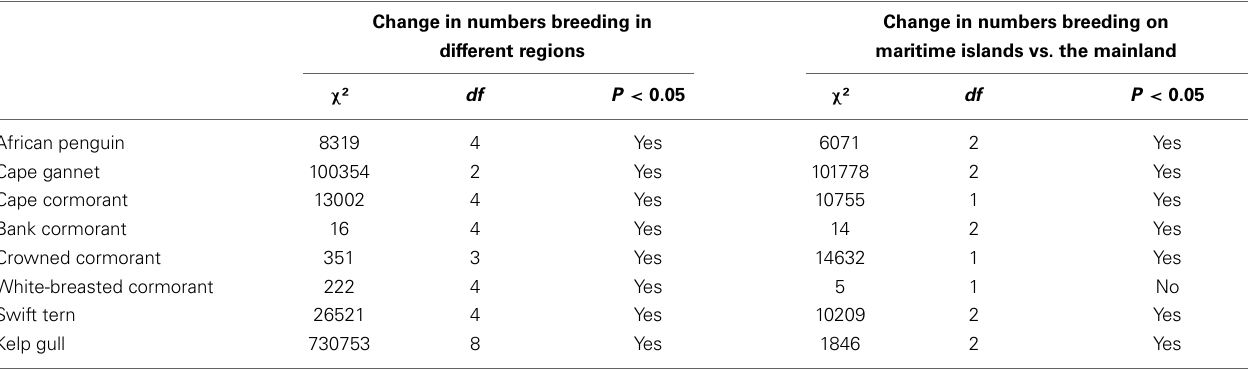
Table 2 | Results of χ ²-tests used to examine the significance of changes in numbers of seabirds breeding in different regions and at maritime islands as opposed to the